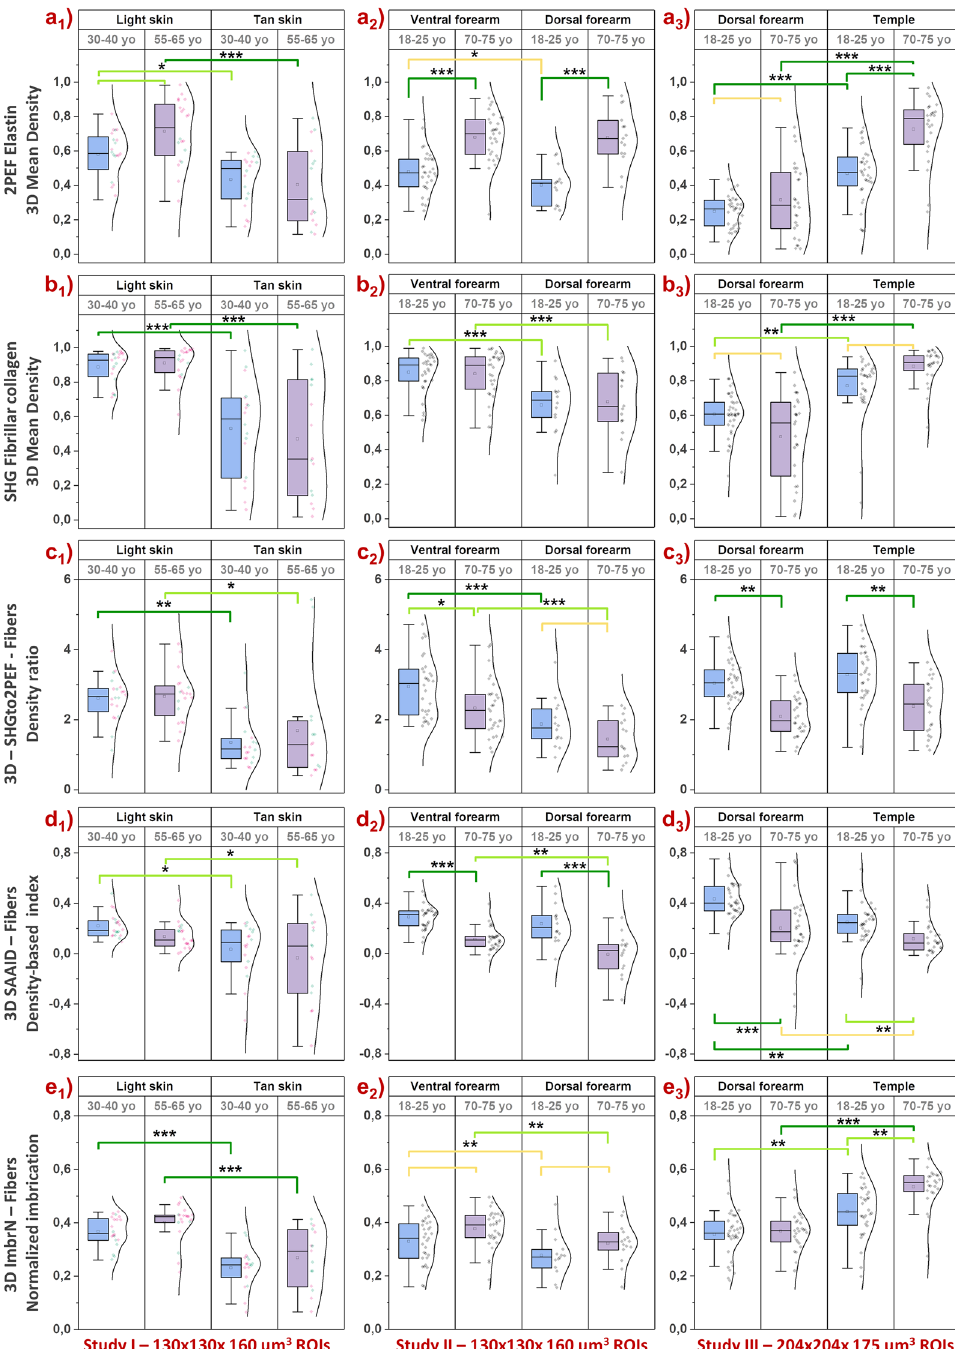
Figure 7. Multiphoton — Aging differences in the 3D density and organization parameters of elastin and collagen fibers networks. Data within the 50-µm thick dermal sublayer from 3 clinical trials: study I acquired with DermaInspect on ventral forearm (30–40 vs 55–65 year-old; “light” ITA vs “tan” ITA skin color groups); study II acquired with DermaInspect on ventral and dorsal forearms (18–25 vs 70–75 year-old); study III acquired with MPT flex on dorsal forearm and face temple area (18–25 vs 70–75 year-old). ( a1 – a3 ) 3D Mean 2PEF elastin fibers density; ( b1 – b3 ) 3D Mean SHG collagen fibers density; ( c1 – c3 ) 3D Mean SHGto2PEF fibrillar collagen to elastin densities ratio; ( d1 – d3 ) 3D Mean SAAID fibrillar collagen and elastin density-based index; ( e1 – e3 ) 3D Mean ImbrN fibrillar collagen and elastin normalized imbrication index. The raw data are expressed as box plots with fences, mean and median (—). All ROIs values and their distribution (dots ( ♦ ) and histogram) are shown on the right side of the boxplot. Overlapping values are highlighted in black ( ♦ ). In study I, the pink ♦ and green ♦ data points correspond to respectively women and men volunteers. The mean and median values with their errors are given in Table S2. All the statistical p -values and ES—effect sizes parameters are given in Table S3. Statistically significant p -values: *≤ 0.05; **≤ 0.01, ***≤ 0.001. The colored brackets indicate the ES—effect size (dark green—very strong [1.3–Inf], light green— strong [0.8–1.3] and yellow—moderate [0.5–0.8]). Only p -values associated with moderate to very strong ES are